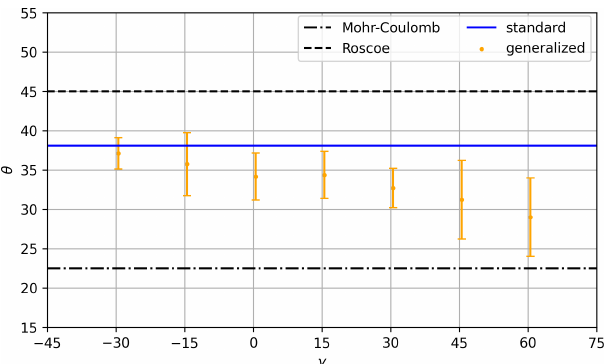
Figure 7. Sensitivity of the LKF orientation θ on the stress correc- tion path angle γ (degrees) in uniaxial loading experiments using the generalized stress correction schemes. The theoretical LKF an- gles from the Mohr–Coulomb and Roscoe theories are indicated by dashed–dotted and dashed lines, respectively, for reference.